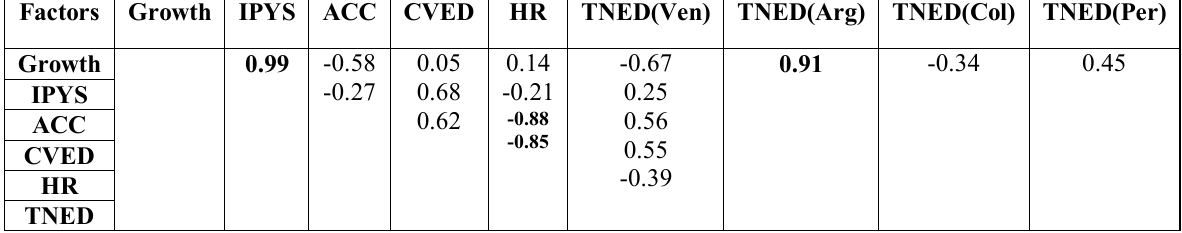
Table 4: Correlation Coefficients Matrix of Venezuela and Correlation Coefficients of Growth with Total NED of Argentina, Colombia and Peru Factors Growth IPYS ACC CVED HR TNED(Ven) TNED(Arg) TNED(Col) TNED(Per) Growth 0.99